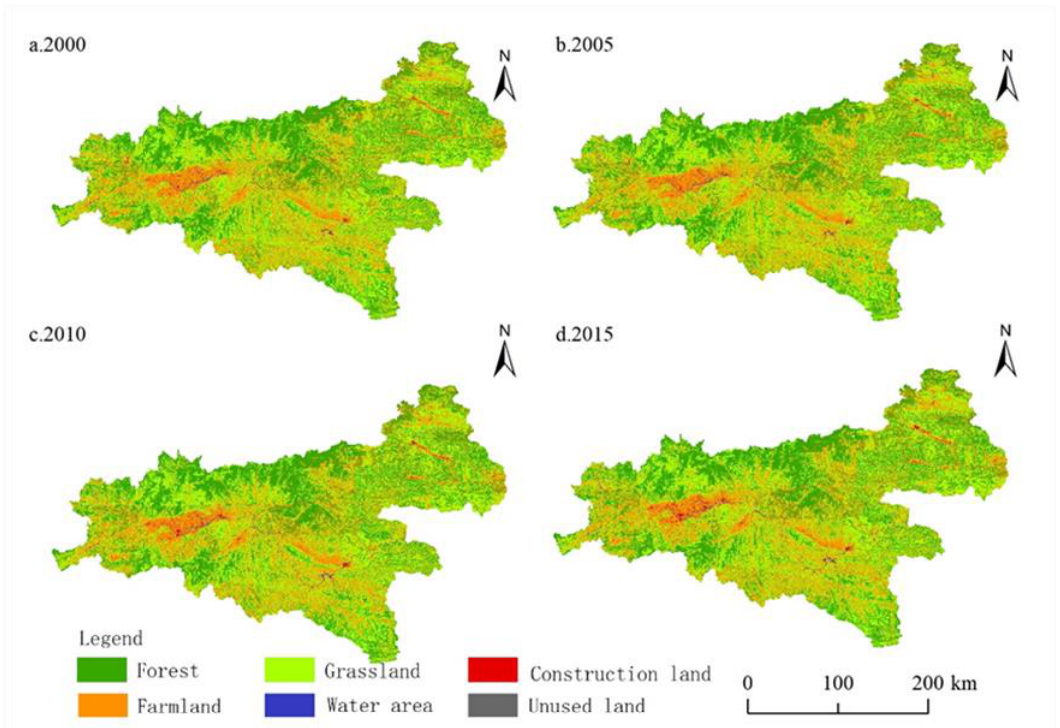
Figure 3. Spatial pattern of ecosystems in the Qinba Mountains in ( a ) 2000, ( b ) 2005, ( c ) 2010, and ( d ) 2015.